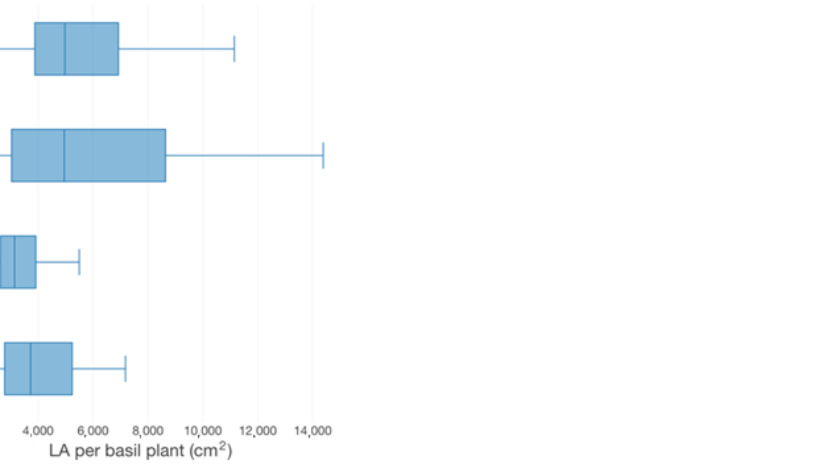
Figure 5. Boxplot for LA per basil plant for each experimental variant, at the end of the trial.